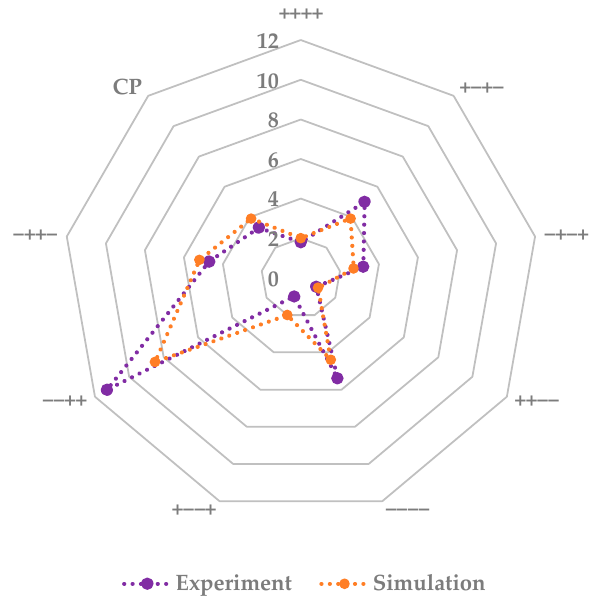
Figure 8. Quantification of edge effect for primary drying time difference.